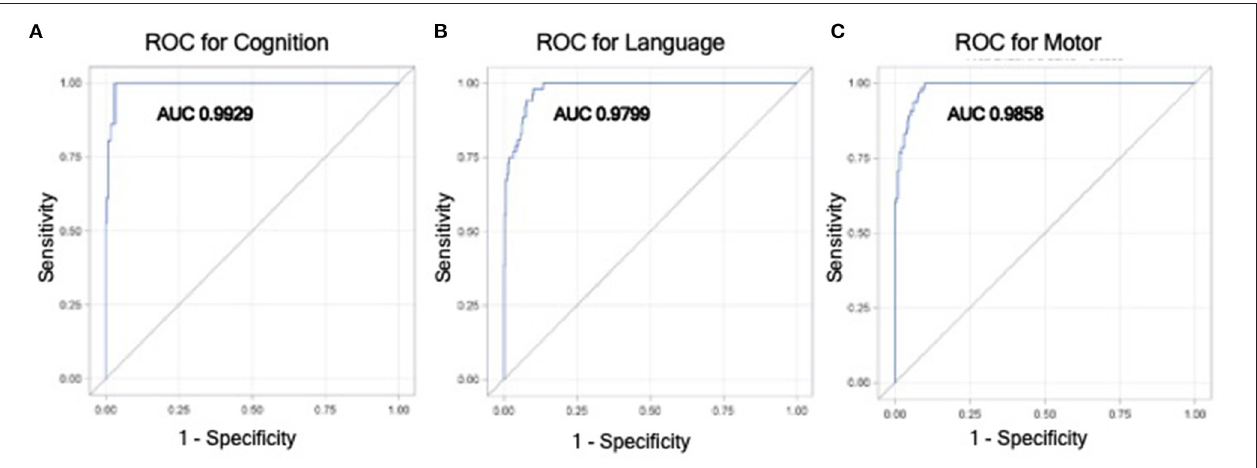
FIGURE 2 | Receiver operator curves (ROC) from the generalized linear mixed effect model for having moderate to severe impairment vs. no to mild impairment in cognitive (A) , language (B) , and motor (C) domains. This model utilizes variables that were found to be significantly associated with worse neurodevelopmental outcomes in mixed effect modeling, which included birthweight, male sex, higher IVH grade, public insurance, and age at Bayley